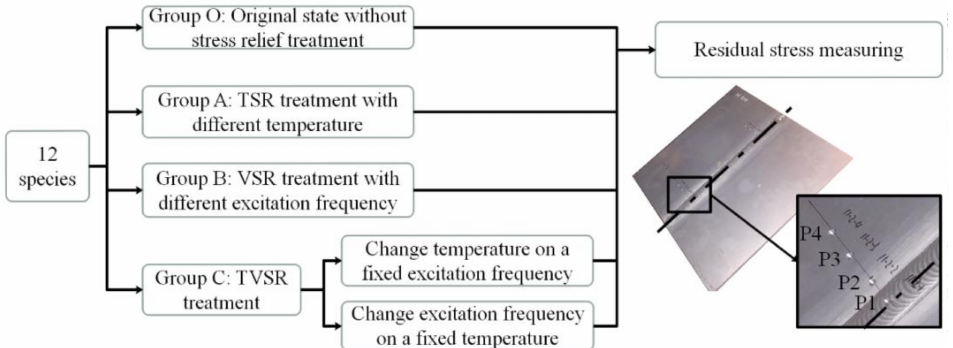
Figure 2. Grouping conditions of the residual stress relief tests.